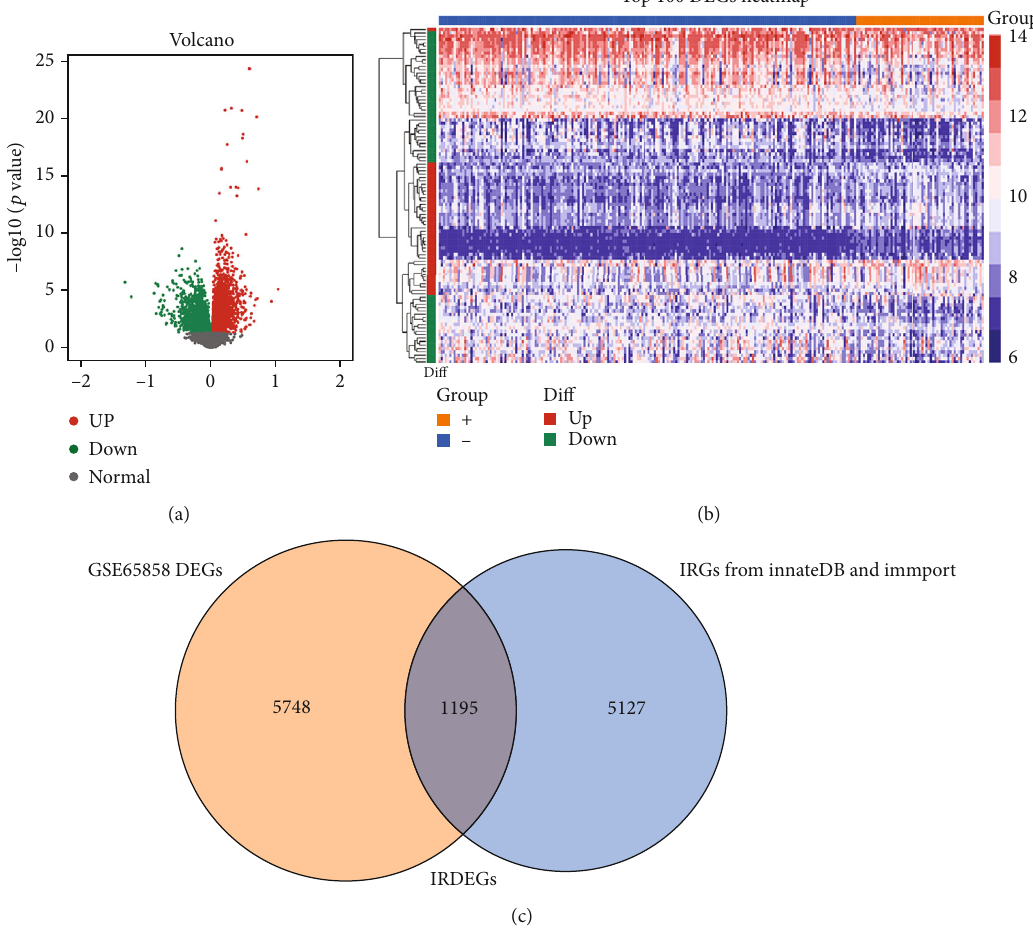
Figure 2: Overview of IRDEG pro fi ling in HNSCC. (a) The DEGs between HNSCC tissues and normal tissues of dataset GSE65858. The DEGs identi fi ed in HNSCC were visualized in a volcano plot. The red and green points in the plot represent DEGs with statistical signi fi cance ( p < 0 : 05 ). (b) Heat map of the top 100 DEGs. (c) The two datasets had an overlap of 1,195 adj :